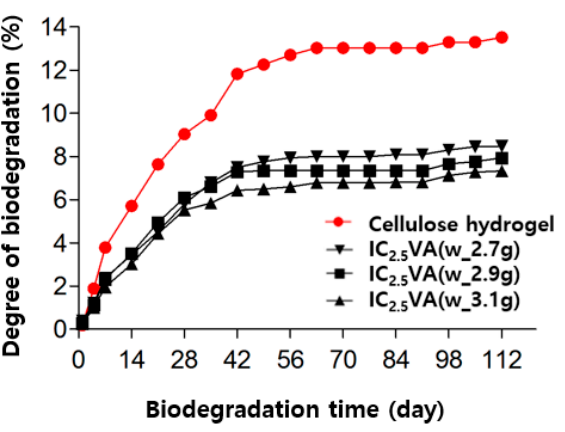
Figure 8. Degree of biodegradation according to water content in surface-crosslinking solution.